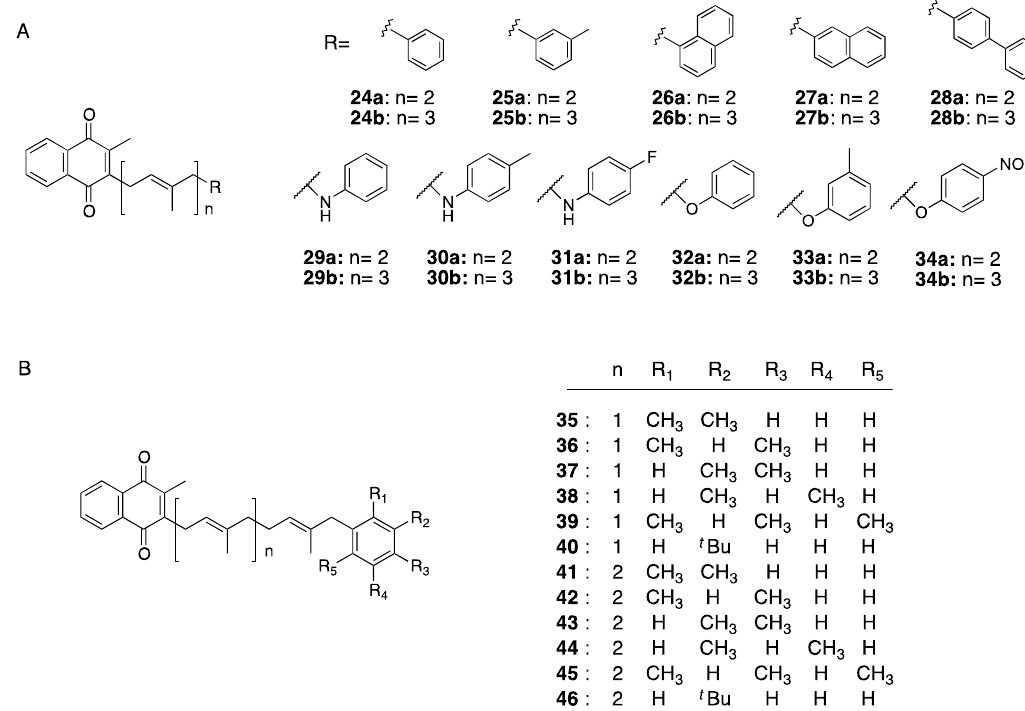
Figure 6. Vitamin K derivatives with neuronal differentiation-inducing activity. ( A ) Derivatives introduced an aromatic ring, or an aromatic ring and a heteroatom, ( B ) Derivatives having a phenyl group with a t-butyl and methyl groups.